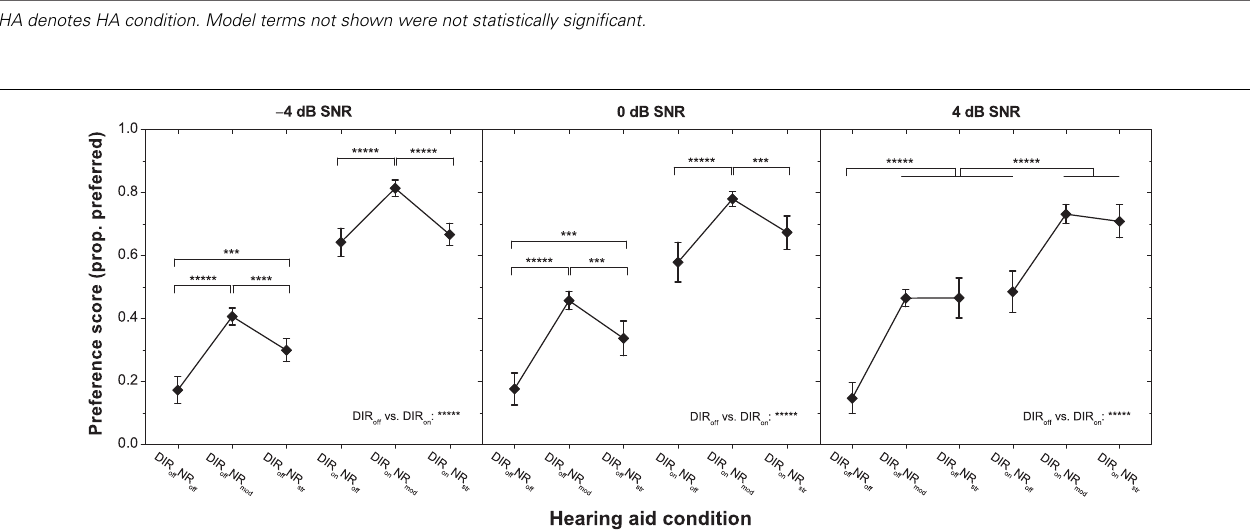
Table 5 | Results from the ANOVAs performed on the preference scores corresponding to − 4, 0, and 4dB SNR. Model term